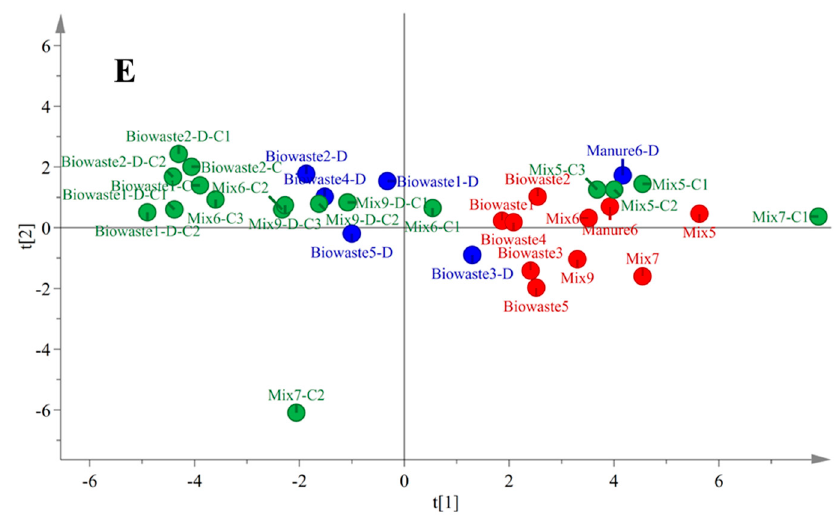
Figure 3. PCA score scatter plot of first two principal components on 34 variables of all the samples (red points − organic waste; blue points − digestate; green points − compost). ( A ) Score scatter plot of all the samples; ( B ) Groups 1 and 2; ( C ) Group 3; ( D ) Group 4; ( E ) Group 5.